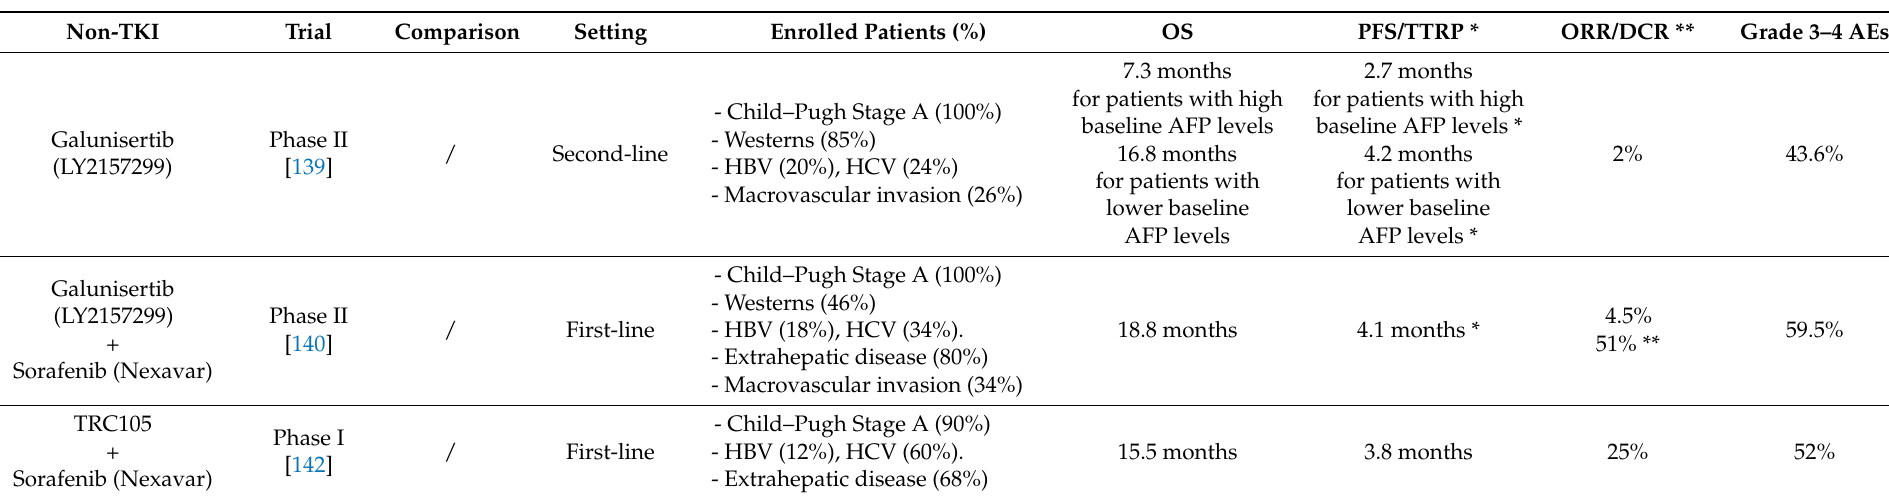
Table 4. Non-tyrosine kinase inhibitors targeting the extracellular space or